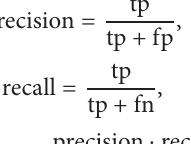
different crowd behaviors are indicated with different